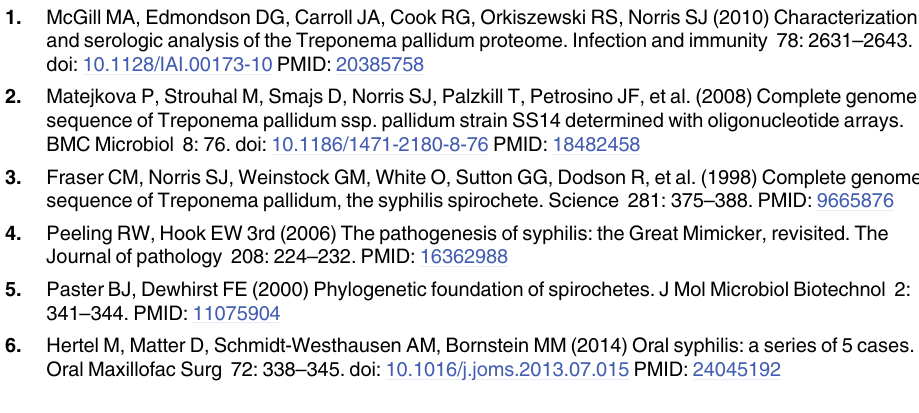
S7 Table. List of functionally annotated domain of 100 proteins with known function from T . pallidum ssp . pallidum by CATH, SUPERFAMILY, PANTHER, CDART, Pfam, SYSTERS, and ProtoNet for ROC analysis.